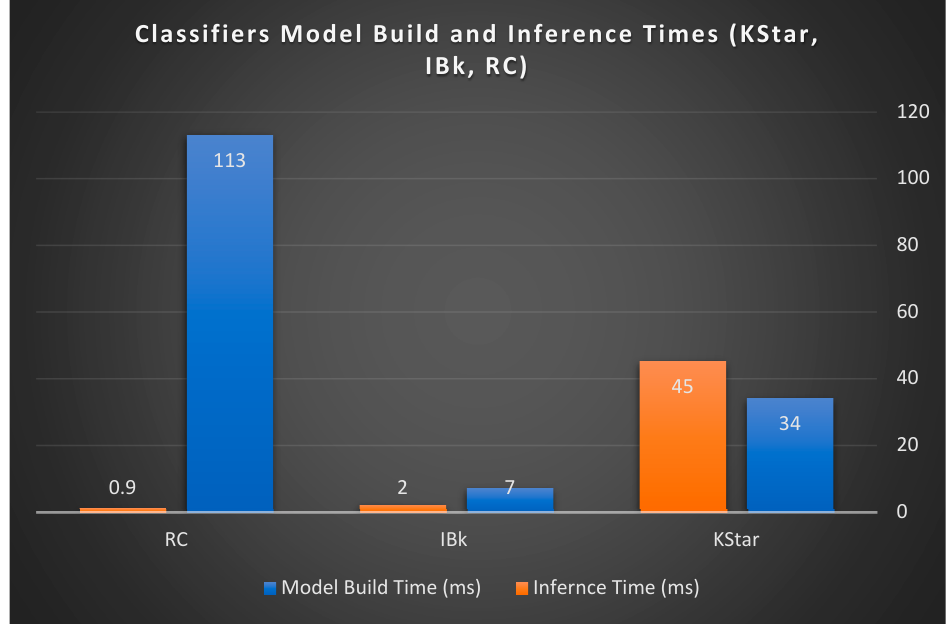
Figure 18. Model build and inference times (top three classifiers: KStar, IBk, RC).